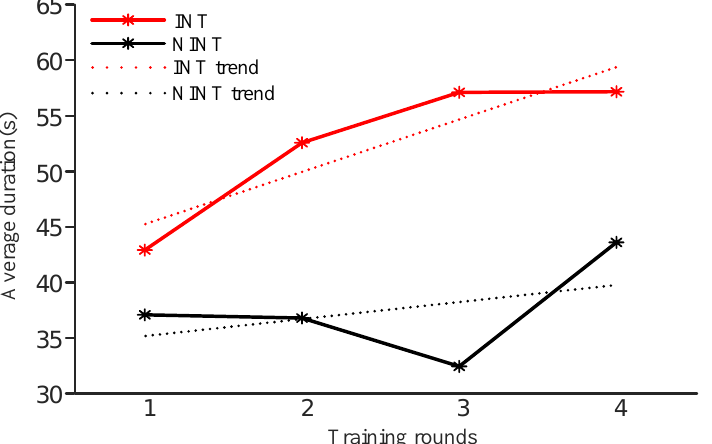
Figure 6. For both groups, the change in duration of Oxy-Hb concentration was higher than the threshold during the neurofeedback